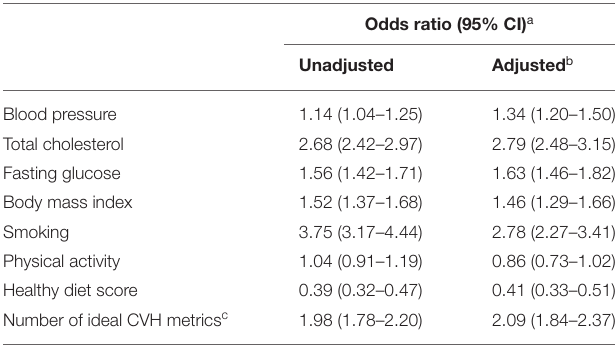
TABLE 2 | The odds ratio for the number of ideal cardiovascular health metrics between vegetarian and